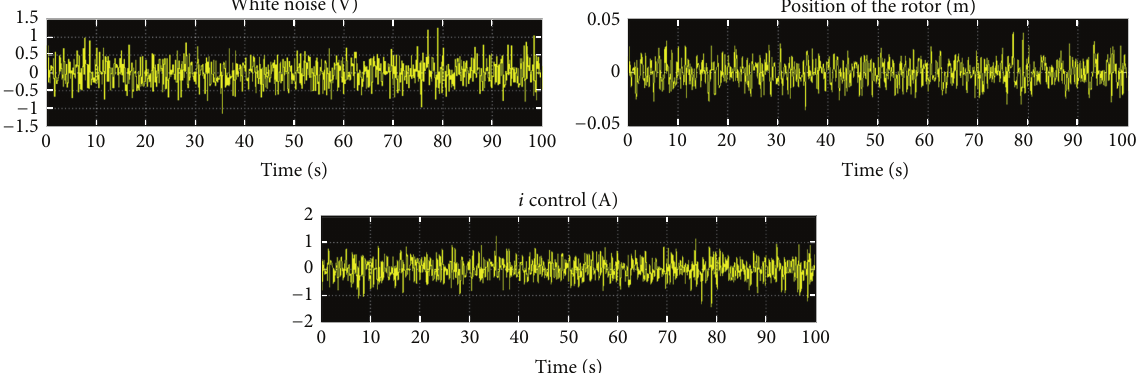
Figure 12: System response with PID controller with proportional gain of 22.1426, integral gain of 23.2457, and differential gain of 283.4574 and white noise of 0.01 volts.